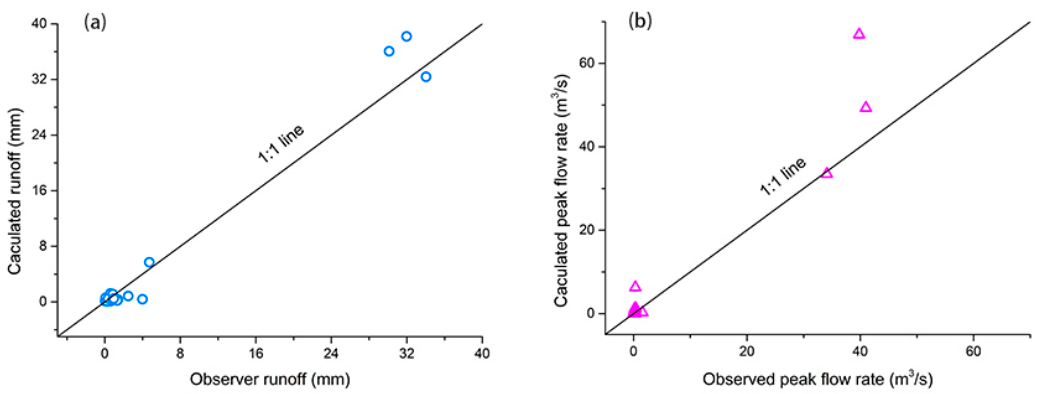
Figure 7. Scatter diagrams between observed and validated runoff (a) and peak flow rate (b).